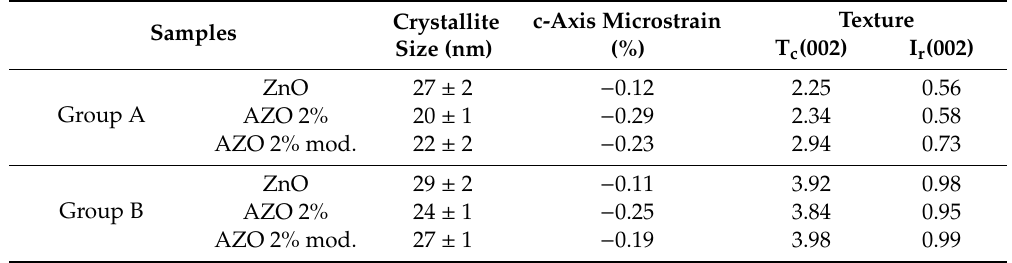
Figure 4. X-ray diffraction patterns for the powder particles and Group A and Group B samples after the final heat treatment. Table 3. The results of line profile analysis on the fitted peaks of thin films, as illustrated in Figure 4 for Group A (upper section) and Group B (lower section).